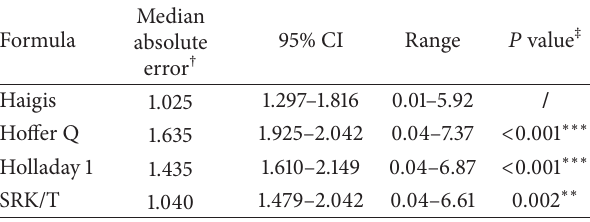
Table 2: Absolute error (D) for each formula.